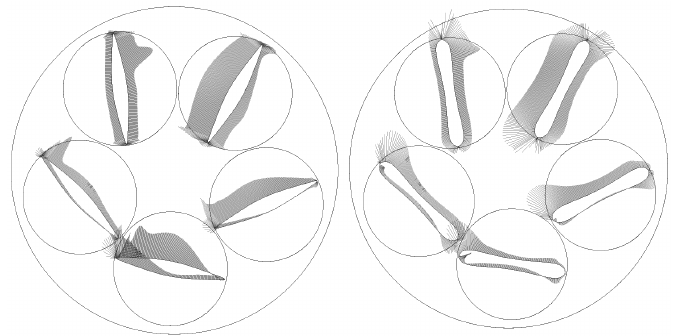
Figure 15. Force distribution on the standard blade (No. 4) ( left ) compared to the best variant (No. 1) ( right